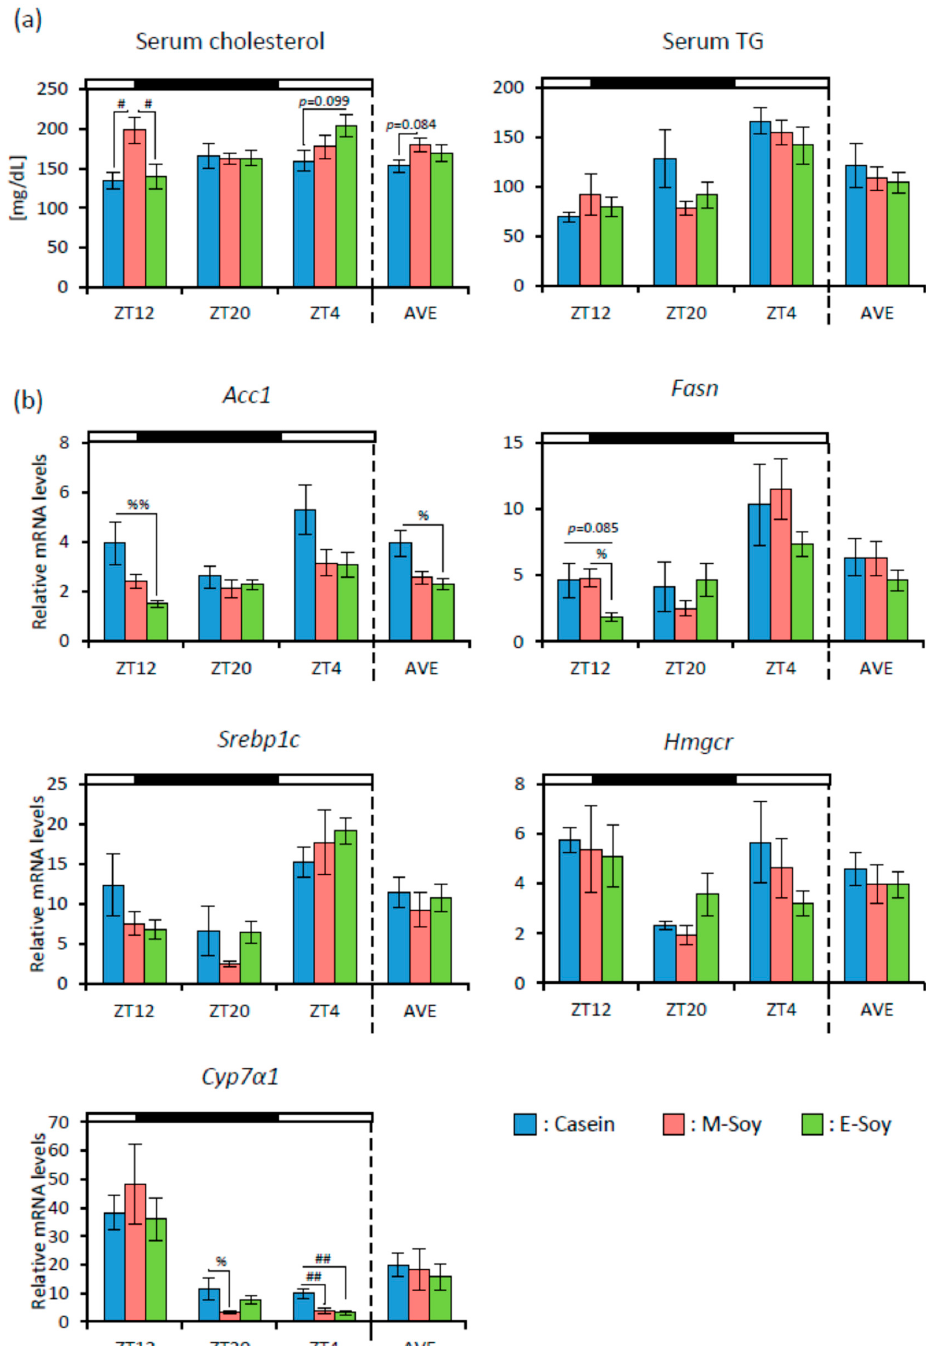
Figure 6. Serum lipid levels and gene expression levels in the liver. ( a ) Serum cholesterol and triglyceride levels (ZT12, ZT20, ZT4, and an average of three points) of mice that were kept in each feeding condition for two weeks. ( b ) Relative RNA expression levels of fatty acid and cholesterol metabolism-related genes in the liver (ZT12, ZT20, ZT4, and an average of three points) of mice that were kept in each feeding condition for two weeks. Data are represented as mean ± SEM ( n = 5). # p < 0.05, ## p < 0.01 evaluated using one-way ANOVA with Tukey’s post-hoc test. % p < 0.05, %% p < 0.01 the Kruskal-Wallis test with Dunn’s post-hoc test. High-fat diet, casein diet feeding, morning soy protein diet feeding, evening soy protein diet feeding, the average value of three points: HFD, Casein, M-Soy, E-Soy, AVE, respectively.